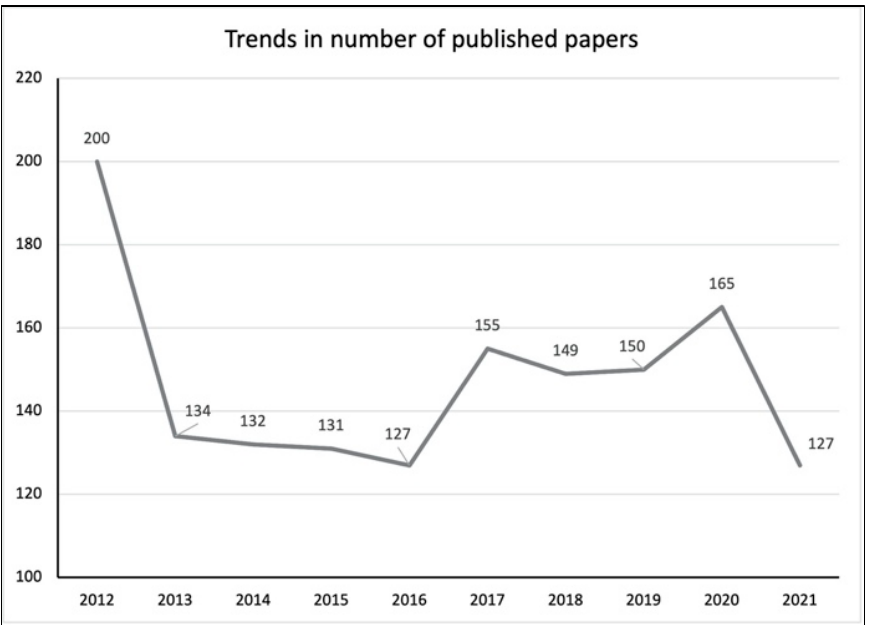
Figure 1. Trends of publication in the field of small animal reproduction. The trends are irregular, and the most prolific year was 2012 ( n = 200), followed by 2020 ( n = 165). Table 1. Distribution of the retrieved documents by research areas according to Web of Science.